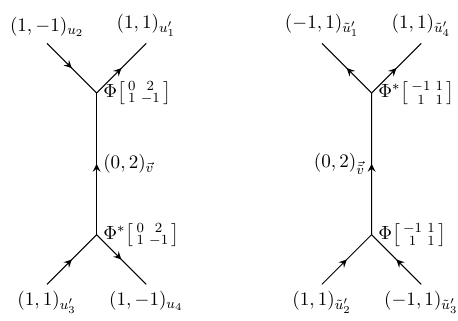
Figure 6 . Folded version of the two dual U(2)